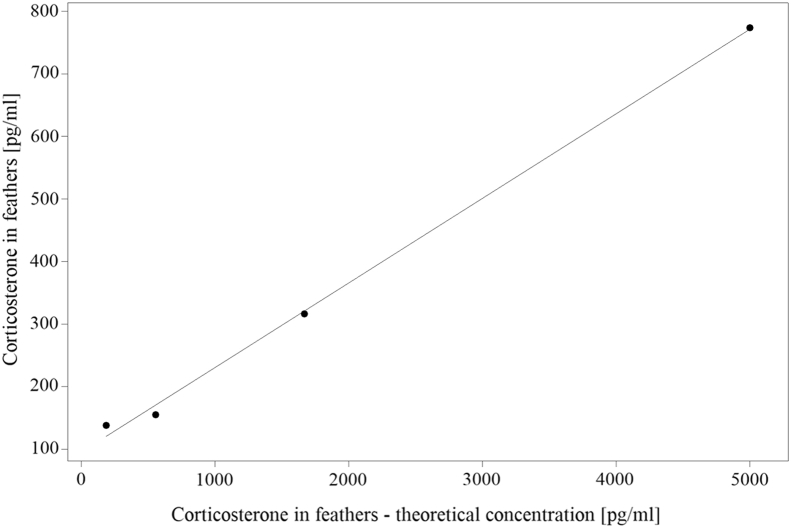
Linearity of the serial dilution.